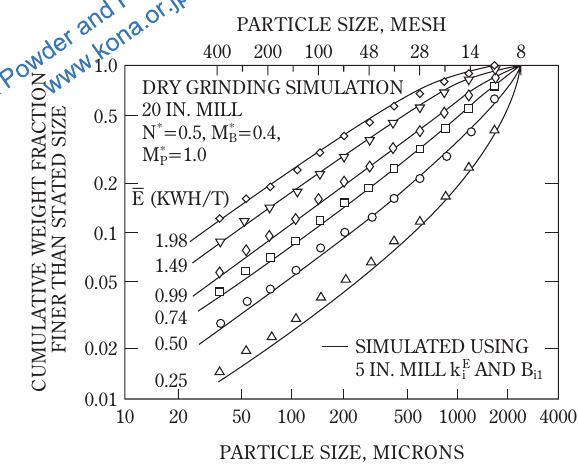
Fig. 6 Comparison of experimentally determined size distribu- tions and those Predicted for grinding 8 (cid:4) 10 mesh lime- stone in a 20-inch (50.8 cm) diameter mill, using breakage rate and breakage distribution functions obtained from grinding the same material in the 5-inch (12.7-cm)